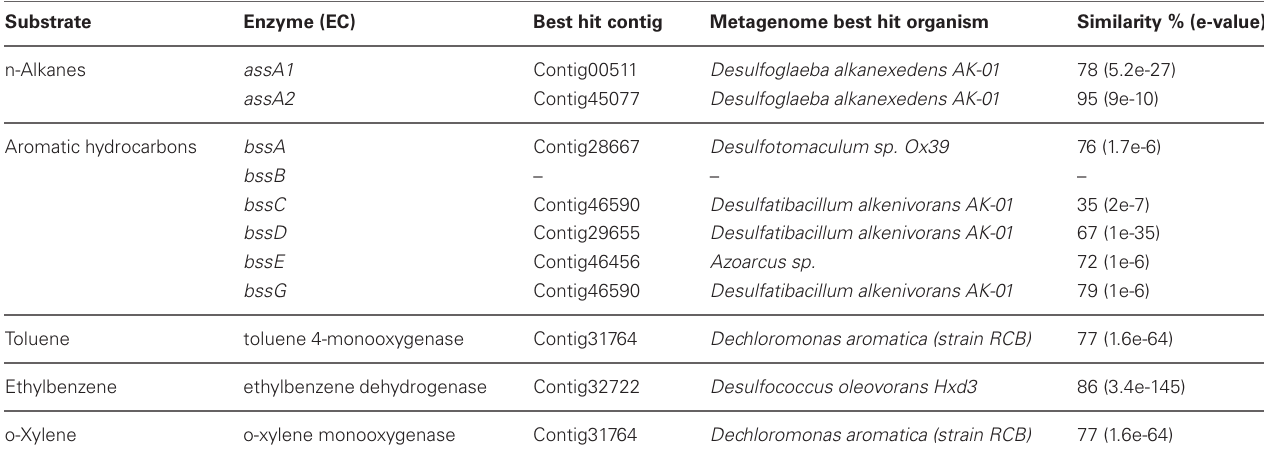
Table 5 | List of annotated gene features involved in degradation of hydrocarbons, absense of gene was marked with